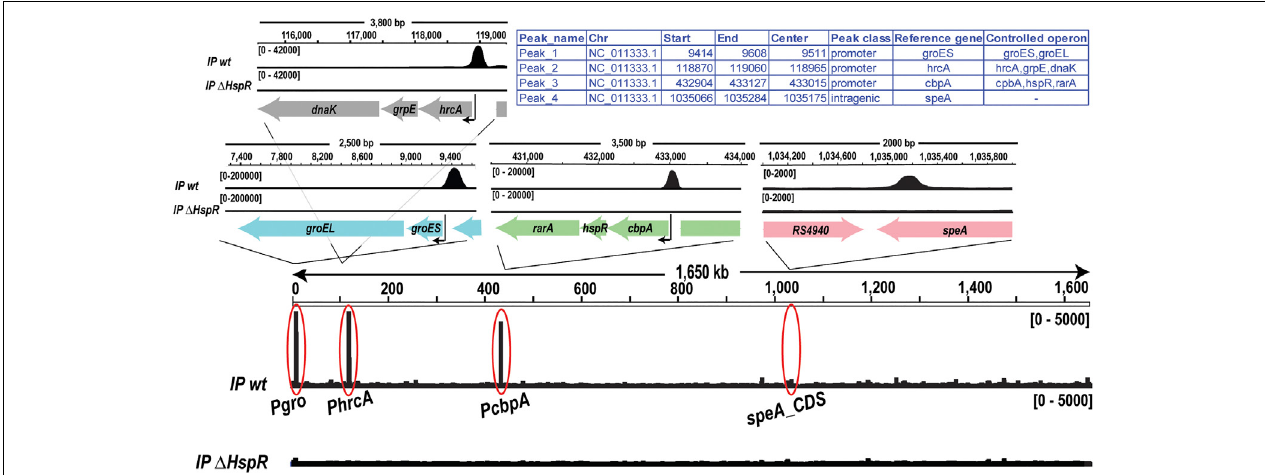
FIGURE 2 | Genome-wide in vivo identification of the HspR binding sites. Genome-wide signals of HspR bindings in the wild type genotype (IP wt, upper track) and in hspR deletion mutant used as negative control (IP (cid:49) HspR, lower track). The regions corresponding to the four HspR binding sites revealed by the analysis are magnified in the upper panels showing each peak in its genomic context including annotated genes (thick arrows) and the transcriptional start site (black thin arrow), when